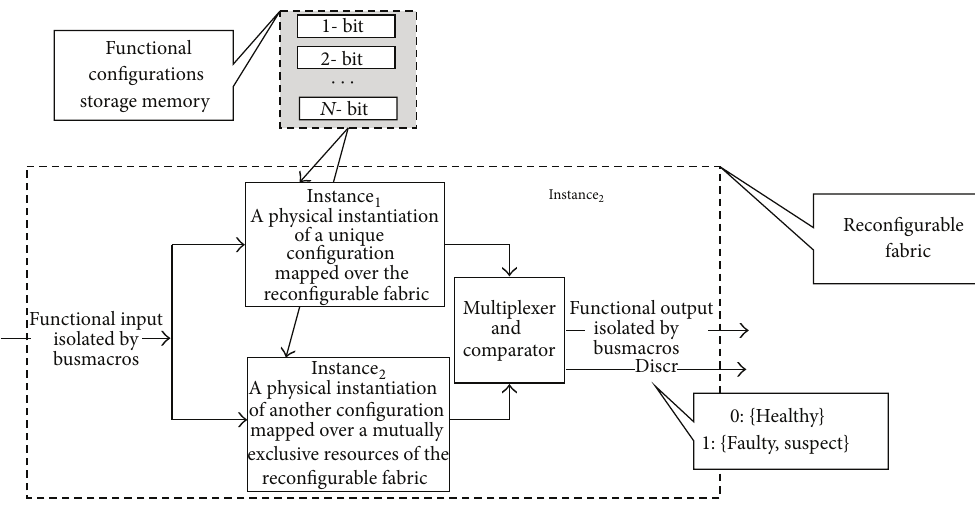
Figure 2: A CED arrangement of a functional